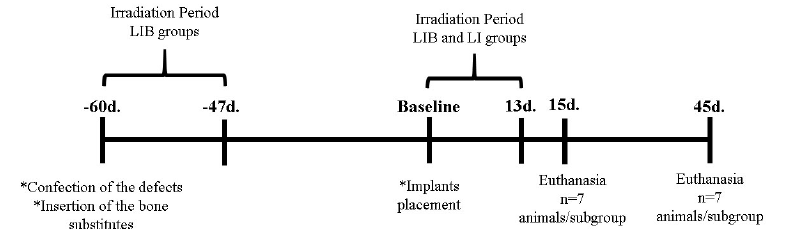
Figure 1- Flowchart of the experiment. LLLT irradiation began after implant placement in the LI groups and after grafting procedures and implant placement in the LIB groups. There were seven sessions that were repeated every 48 hours for 13 days. The implants were installed 60 days after the grafting surgery. The animals were euthanized after 15 and 45 days of implant